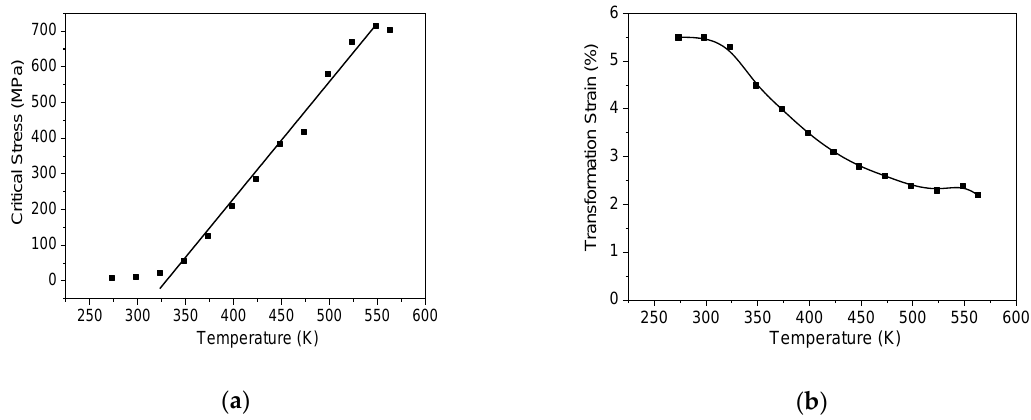
Figure 10. Temperature dependence of the critical stress ( a ), the transformation strain ( b ) for the quenched sample. The solid line in ( a ) shows the region where the linear fit is a good approximation, while in ( b ), it is only to guide the eye.